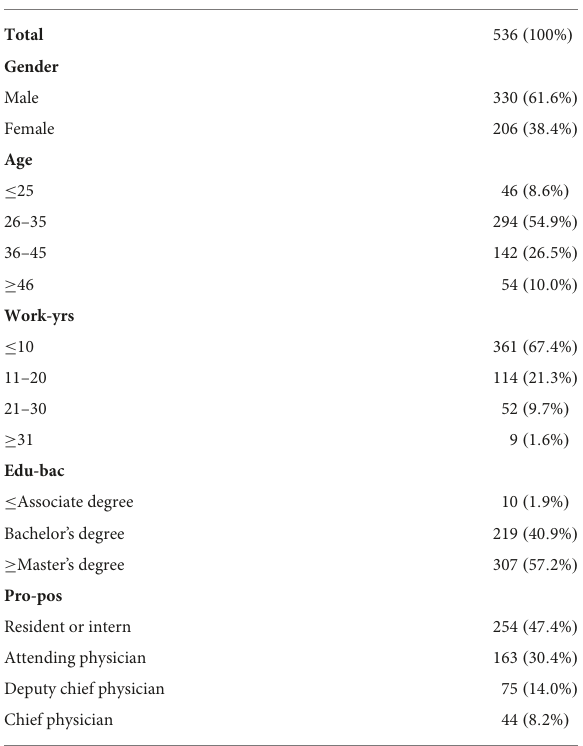
TABLE 2 Descriptive statistics of emergency